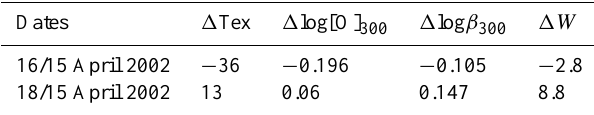
Table 2. Variations of aeronomic parameters for the two pairs of dates.